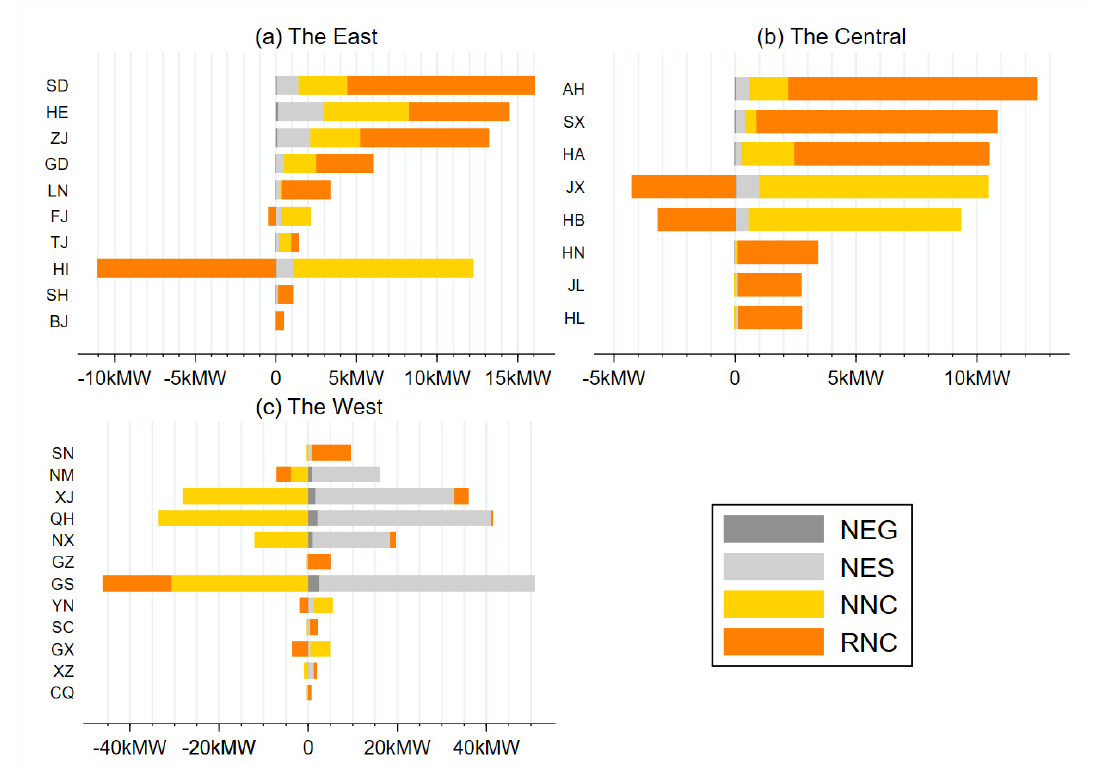
Figure 5. Provincial NEG, NES, NNC, and RNC from 2013 to 2019: ( a ) The East; ( b ) The Central; ( c ) The West.